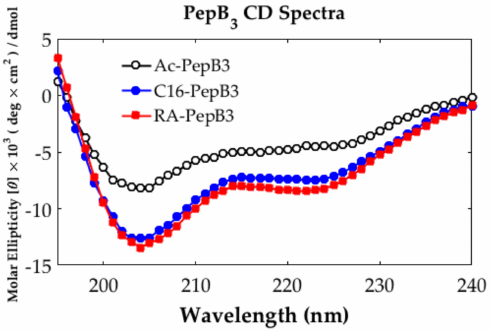
Figure 2. Circular dichroism (CD) spectra of PepB 3 variants. All PepB 3 variants exhibit a mixture of random coil and α -helical secondary structures. The lipidated PepB 3 had more pronounced peak features compared to acetylated PepB 3